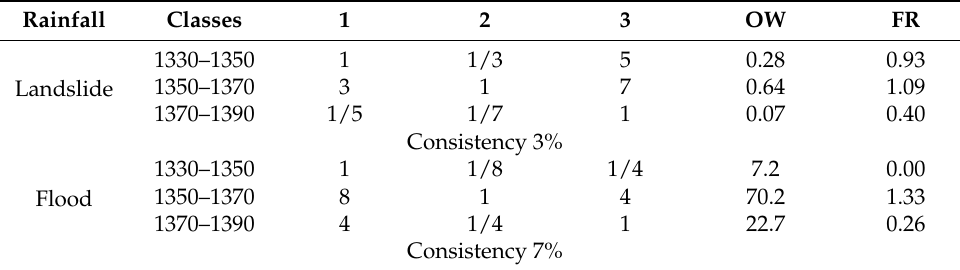
Figure 13. Rainfall causative factor map. Table 14. AHP matrices and OWs for the rainfall causative factor